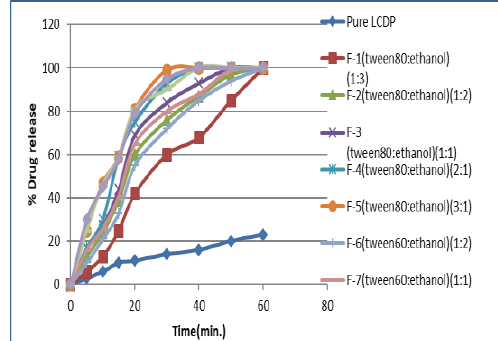
Figure 10.A comparative dissolution